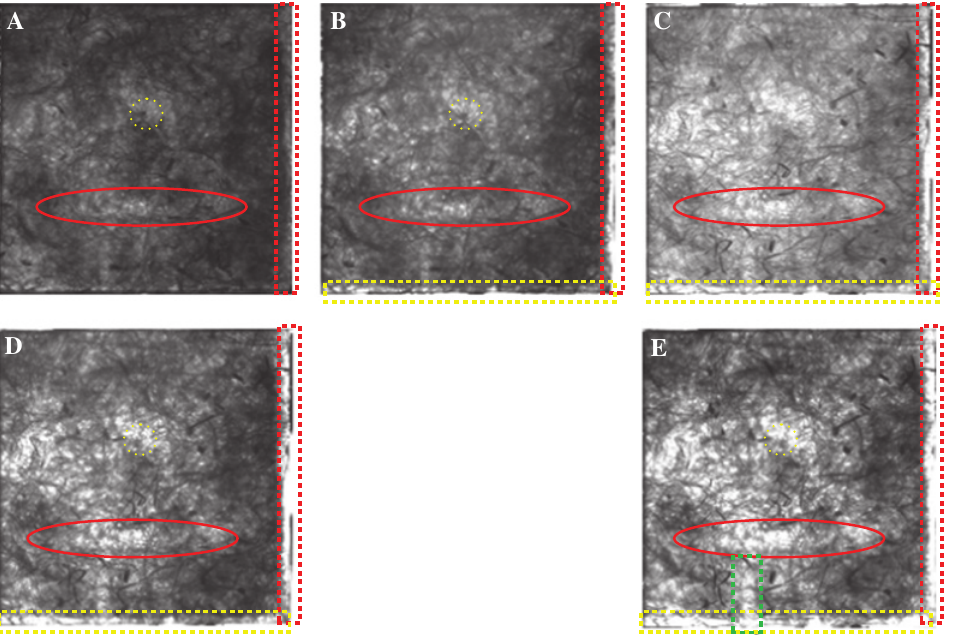
Figure 16 (A) SWIR 940 nm transmission mode (back face), (B) SWIR 1050 nm transmission mode (back face), (C) SWIR 1300 nm transmis- sion mode (back face), (D) SWIR 1430 nm transmission mode (back face), (E) SWIR 1650 nm transmission mode (back